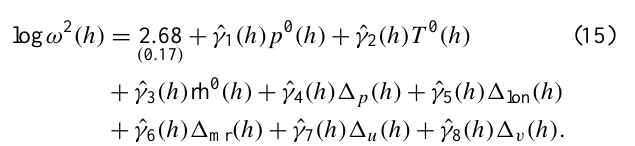
(cid:16) (cid:17) σ ˆ β , irreducible environmental error ( σ ω ) reducible environmental error ( σ x ∼ β 0 ) and constant error